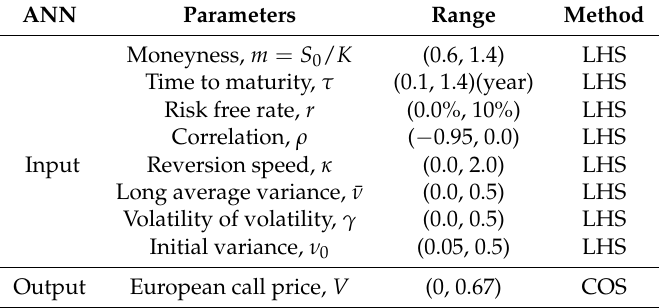
Table 9. The Heston parameter ranges for traing the ANN.